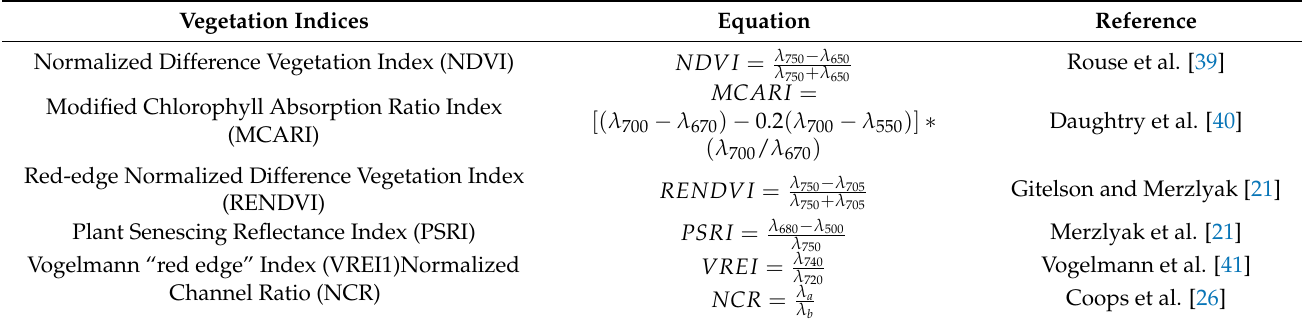
Table 3. Vegetation indices used in this study and the equation used to generate each. Note: The Normalized Channel Ratio was generated from the results of the JM statistical